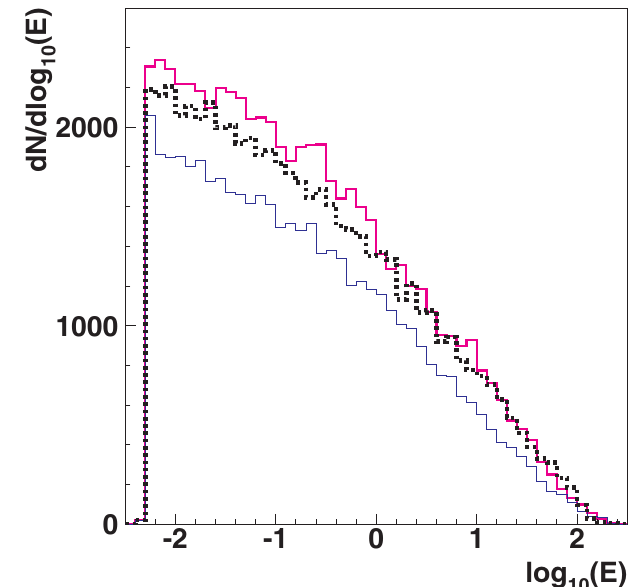
(cid:3) E (cid:4) spectrum for the Landau-Lifshitz pro- FIG. 5. (Color) log 10 cess in GUINEA-PIG (upper line), CAIN (lower thin line) and BDK (dashed line), E being in